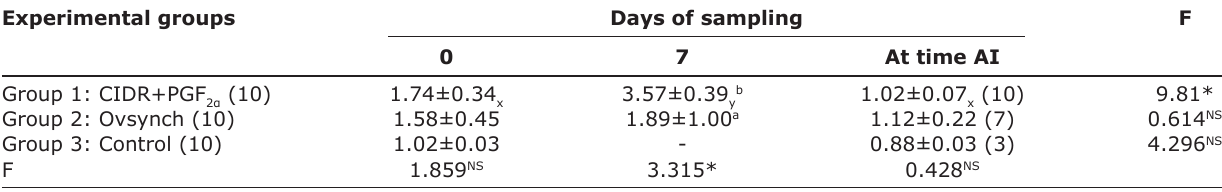
Table-2: Mean serum progesterone concentration (ng/ml) of different experimental groups on different days of sampling in postpartum anestrus cows. Experimental